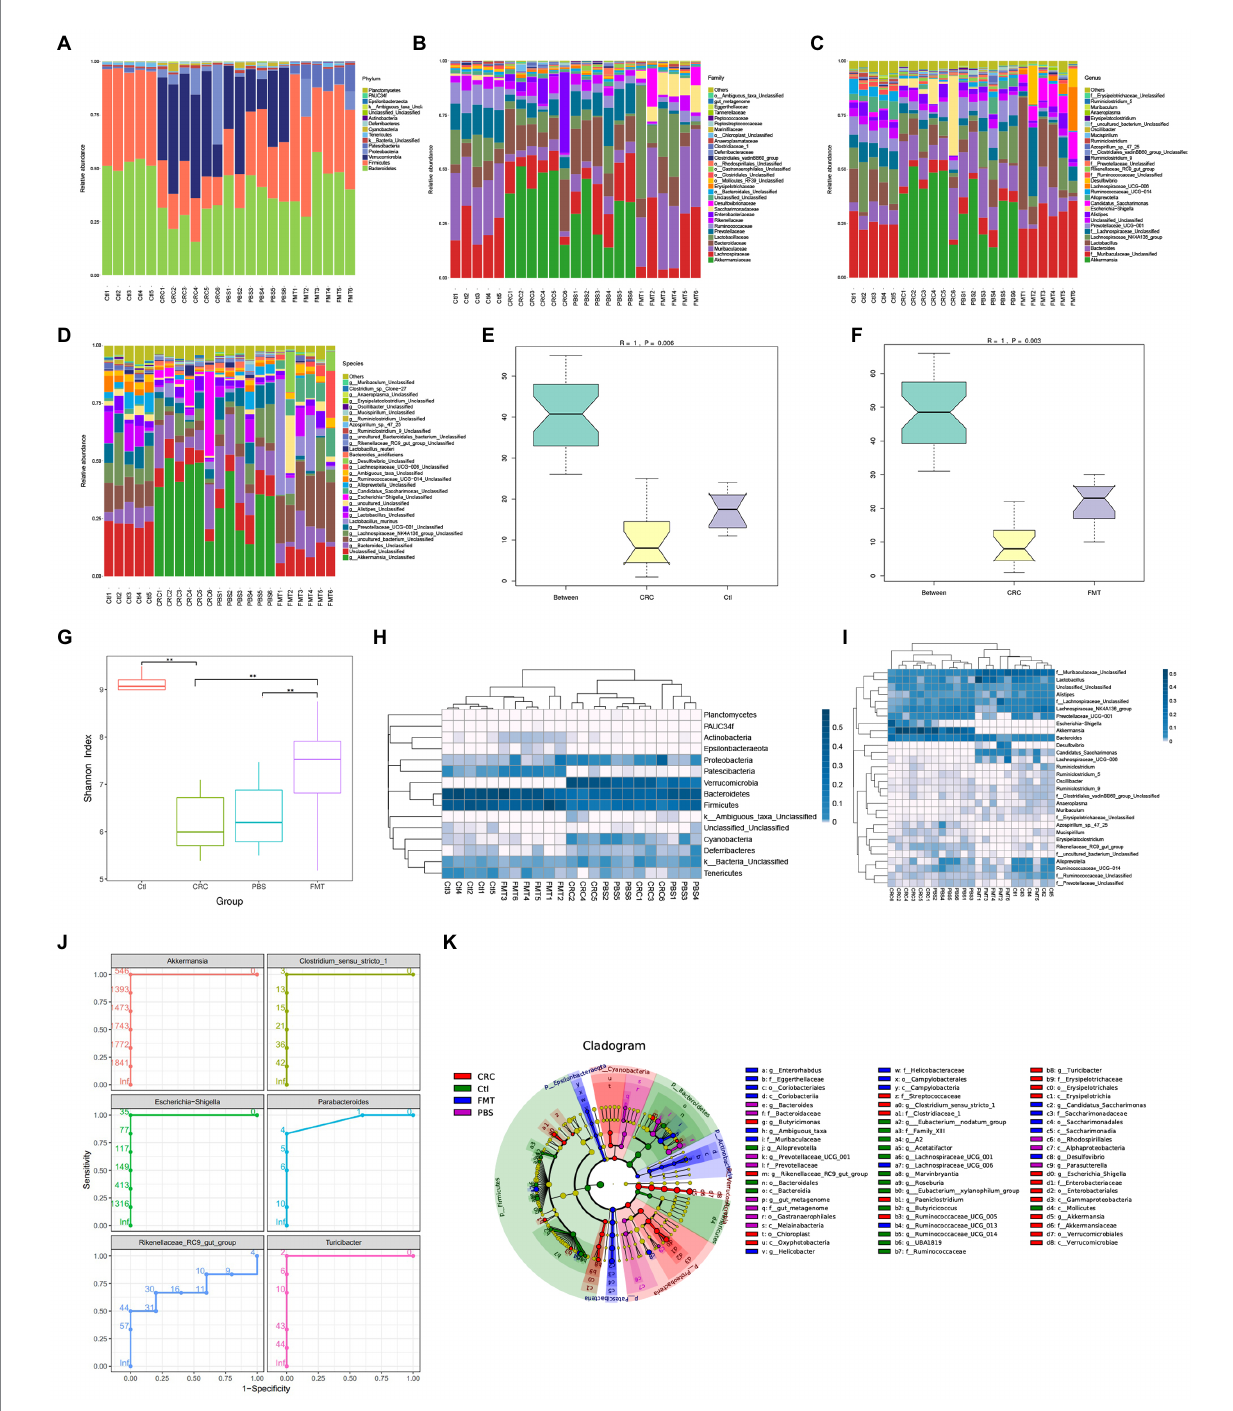
FIGURE 2 FMT restored intestinal microbial abundance and diversity of CRC mice. The distribution of intestinal microbiota in different classification, including phylum (A) , family (B) , genus (C) and species (D) . (E,F) Anosim analysis between samples. The R value towards 1 indicates that the difference between groups is much more than that within groups. p < 0.05 (Ctl, n = 5; CRC, n = 6; FMT, n = 6). (G) Shannon index analysis reflects the diversity of intestinal microbiota, including both microbial richness and evenness. ** p < 0.01, (Ctl, n = 5; PBS, n = 6; CRC, n = 6; FMT, n = 6). (H,I) the weighted unifrac analysis at the levels of phylum and genus, respectively. (J) Receive operating characteristic curve reflects continuous variables of sensitivity and specificity. The area value under the curve prone to 1, indicating that the intestinal bacteria could be considered as marker of CRC mice. (K) LefSe analysis identifies representative bacteria in each